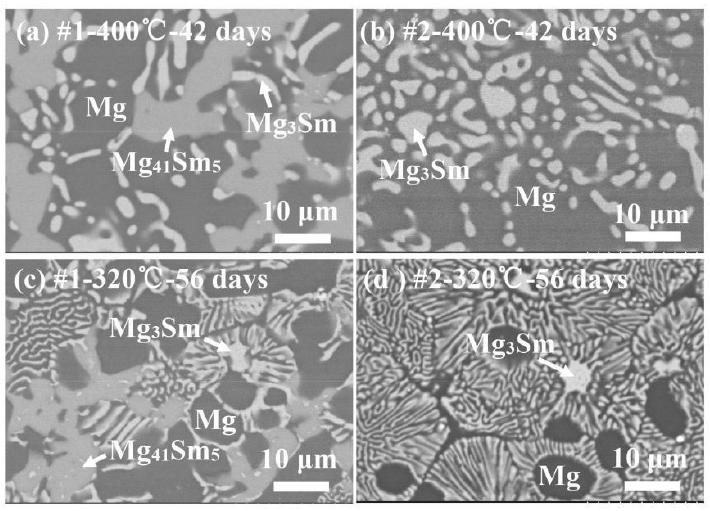
Figure 3. The BSE images of alloys #1 – #2 annealed at ( a , b ) 400 °C for 42 days and ( c , d ) 320 °C for 56 days.